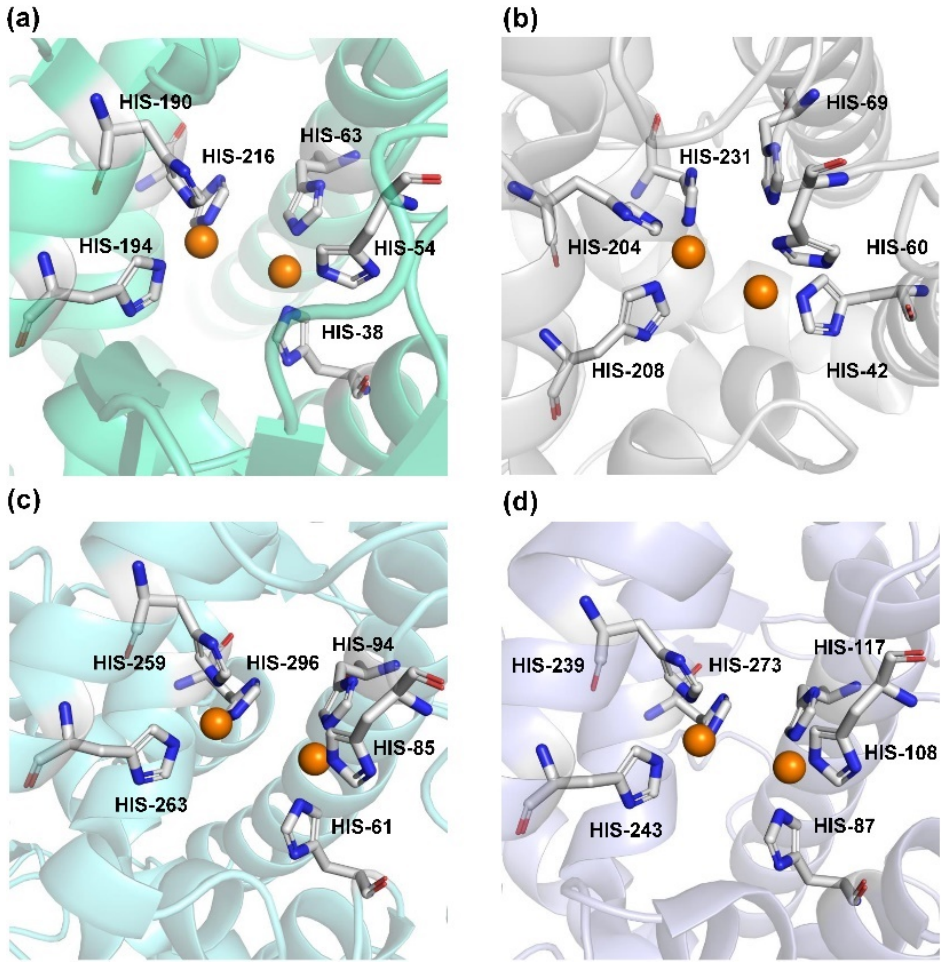
Figure 3. The conserved cavity of TYR from different sources. ( a ) The crystal of TYR from Streptomyces castaneoglobisporus (PDB ID: 2ZMX). ( b ) The crystal of TYR from Bacillus megaterium (PDB ID: 3NQ1). ( c ) The Crystal of TYR from fungus (PDB ID: 2Y9W, Agaricus bisporus ). ( d ) The Crystal of TYR from plant (PDB ID: 5CE9, Juglans regia ). Two copper ions (orange) are coordinated with three histidine residues, respectively.